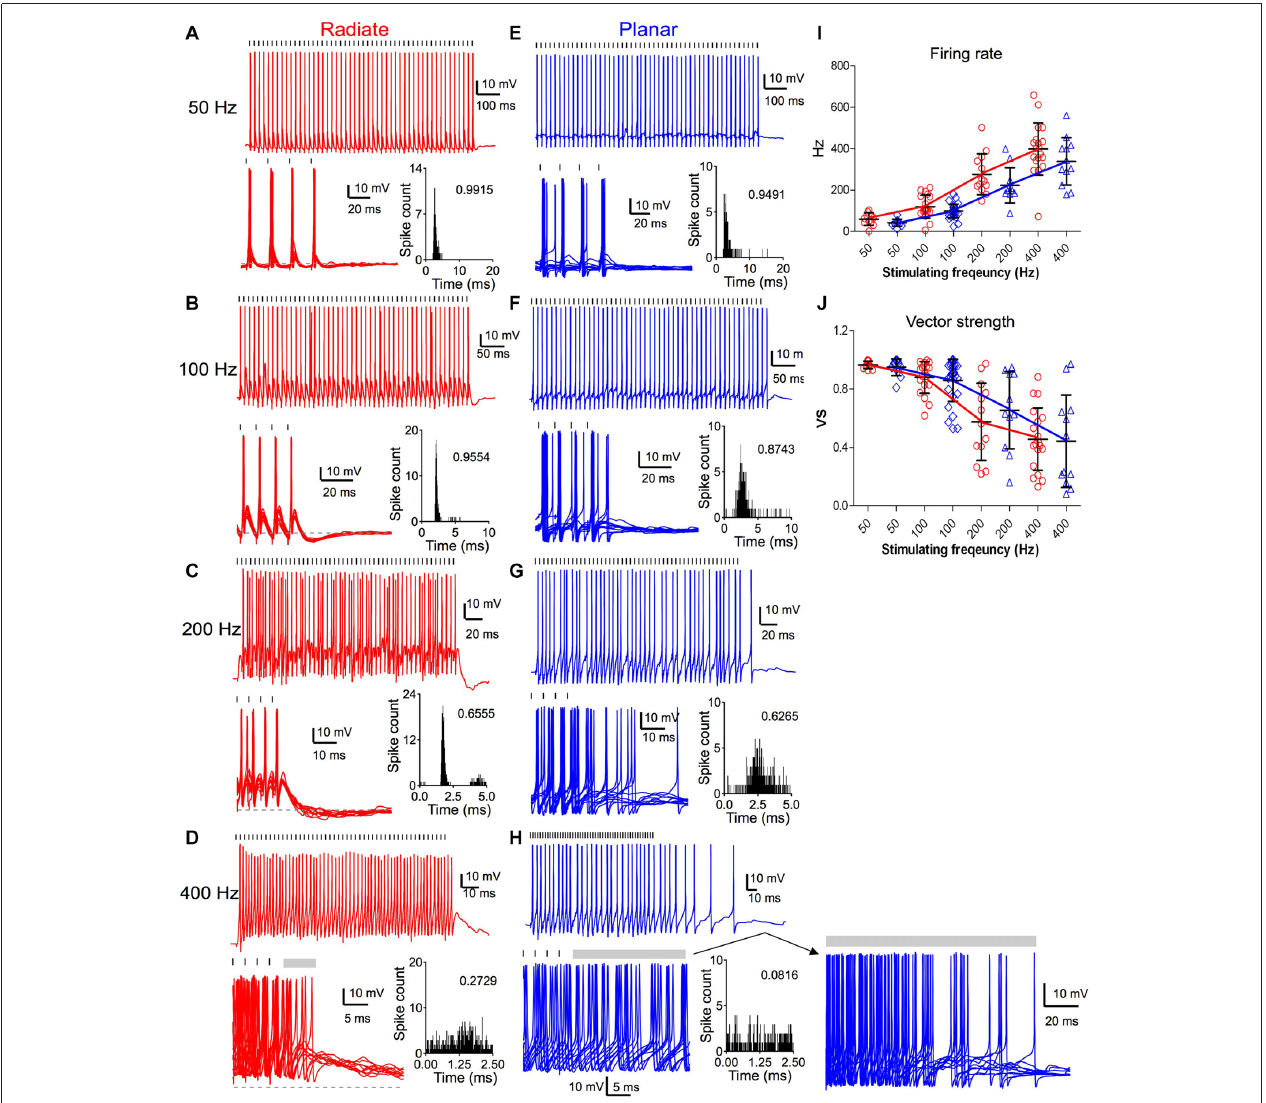
FIGURE 6 | Comparison of suprathreshold spike entrainment between radiate and planar cells. (A) Example responses to 50 pulse stimulus trains at 50 Hz. Top panel: a single trace response to the stimulus train; bottom left panel: overlap of 10 traces to stimulus trains (only the last four stimuli of the trains are shown); gray dashed line marks the resting membrane potential; bottom right panel: overlapped peristimulus time histogram (PSTH) plot to show spike timing within the stimulus cycle; the number in the plot is the calculated vector strength. Tick marks above the traces indicate the timing of the stimulus pulses. (B–D) Example responses of the same radiate cell as in (A) to stimulus trains at 100 Hz (B) , 200 Hz (C) and 400 Hz (D) . Labels and layout are the same as in (A) . Gray bars after the stimulus trains mark the window of delayed spikes in (D,H) . (E–H) Example responses of a planar cell to stimulus trains at 50 Hz (E) , 100 Hz (F) , 200 Hz (G) , and 400 Hz (H) . Notice that the spikes of radiate and planar cells occur at consistent latency relative to the stimulus at 50 and 100 Hz, but increasing latency variability reduces the precision at 200 and 400 Hz. (I) Summary of the firing rates in response to trains of stimulations at different frequencies. (J) Summary of the vector strength